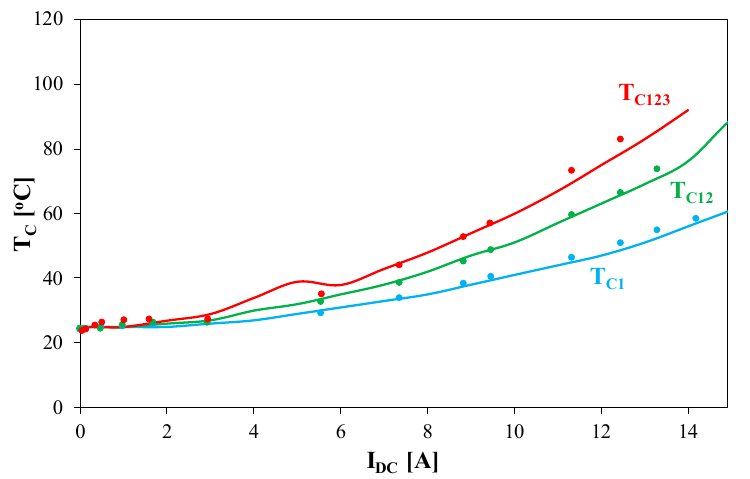
Figure 15. Dependence of the inductor core temperature on the direct current IDC when the current flows through one, two, or three windings connected in series.